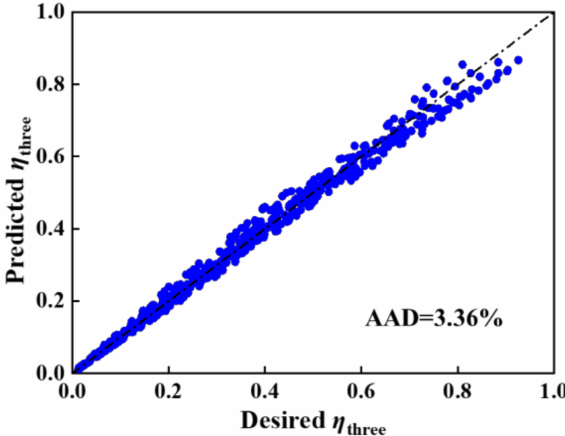
Figure 7. Crossplot between desired and predicted η values for three-layer